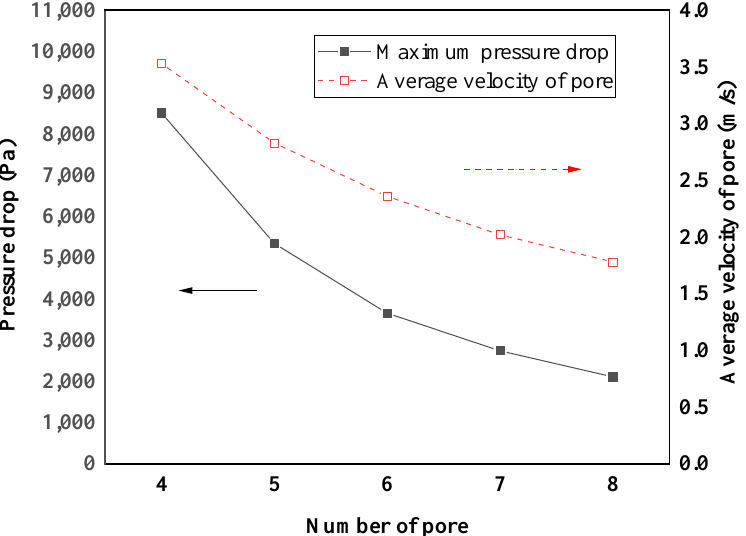
Figure 7. Maximum pressure drop within the water diffuser and average velocity of perforated pores under different numbers of perforated pores.